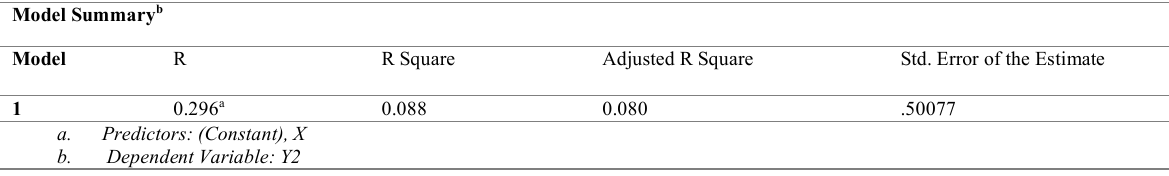
Table 8: Coefficient of Determination of The Effect of Job Crafting on Job Satisfaction